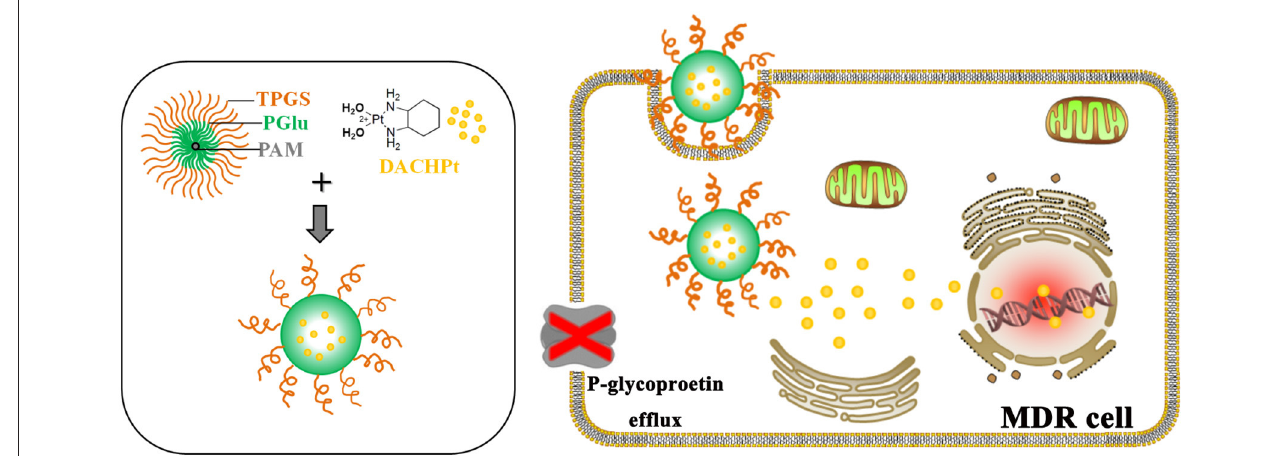
FIGURE 1 | Schematic illustration of overcoming the resistance of A549/DDP cells by